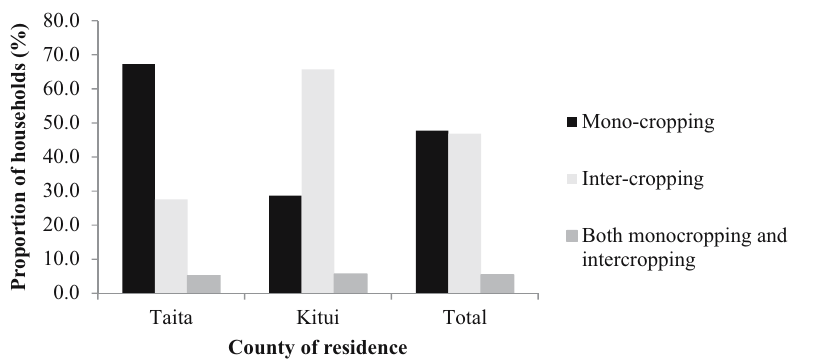
Figure 4: Association between county of residence and system of farming for cowpea leaves. χ 2 = 54.8, p < 0.001 and df = 2.